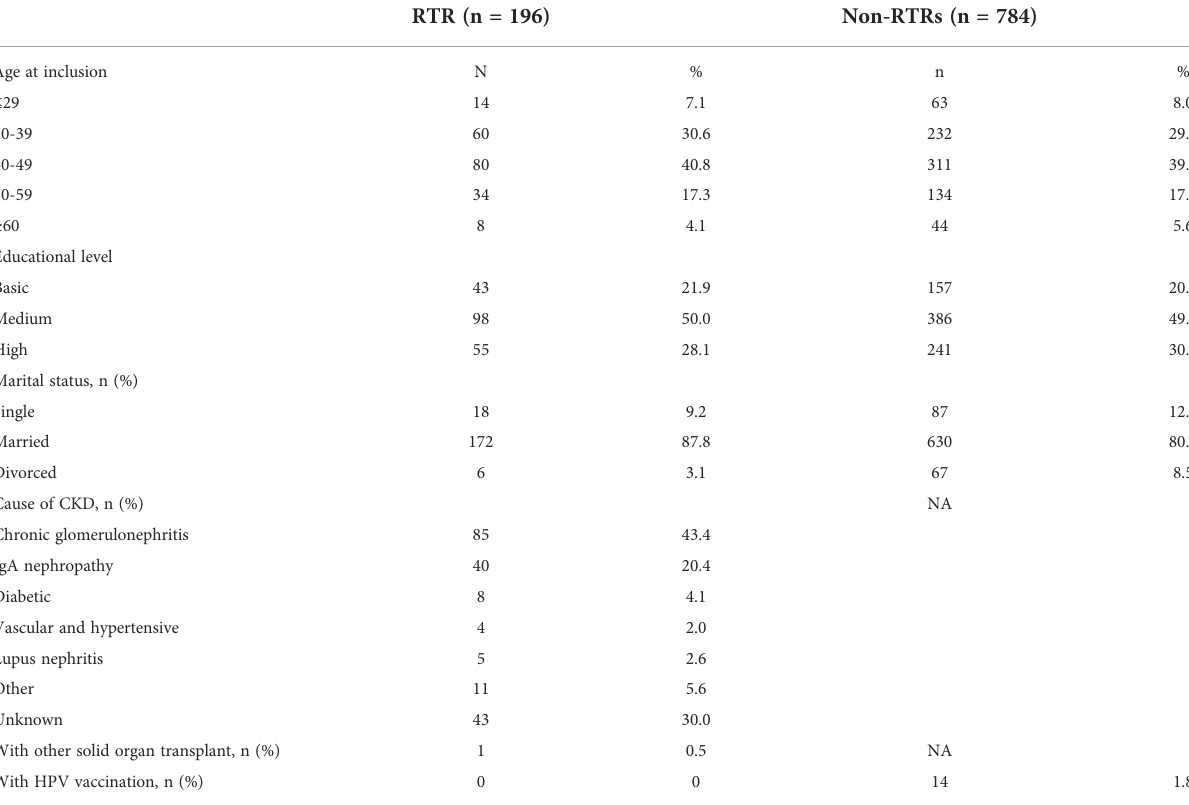
TABLE 1 Baseline characteristics of Chinese renal transplant recipients (RTRs) and a comparison cohort